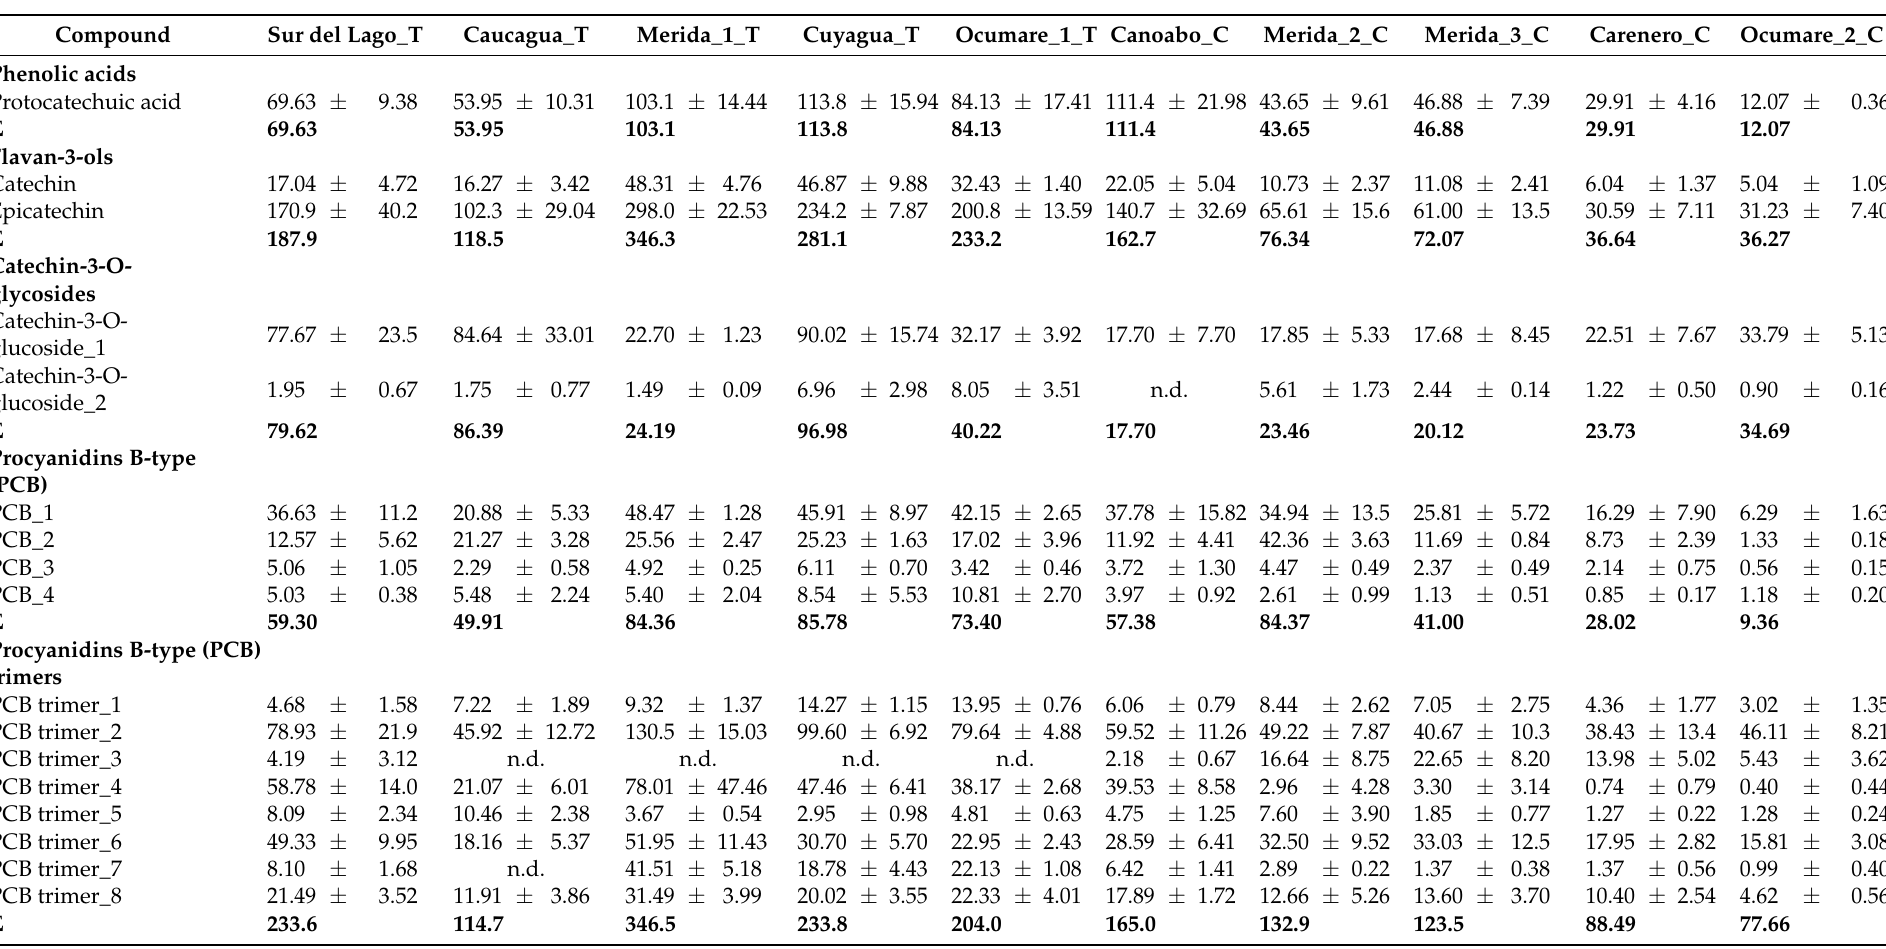
Table 2. Total and individual contents of chemical compounds and spectrophotometric assay results of CBS samples ( n = 10) yielded from cocoa beans from seven different regions of Venezuela and two cultivars, Trinitario ( n = 5) and Criollo ( n = 5). Each origin contains 4 samples from 2 different batches ( n = 40). The content of bioactive compounds for each sample results from the sum of the quantification of the four fractions yielded individually ( n = 120). Data are expressed as mg/kg dw of CBS, except for methylxathines, which are expressed as g/kg dw of